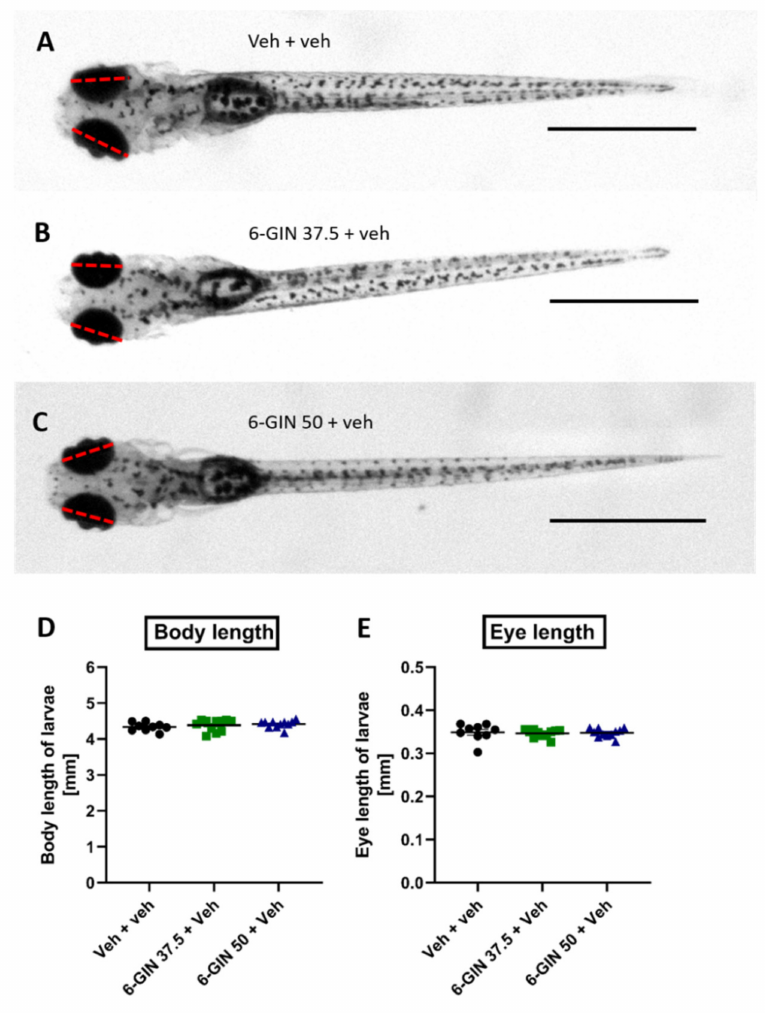
Figure 3. Larvae treated with 6-GIN are morphologically indistinguishable from their Veh-treated counterparts. ( A ) Larva treated with Veh for 24 h ( n = 9). ( B ) Larva treated with 37.5 µ M 6-GIN for 24 h ( n = 11). ( C ) Larva treated with 50 µ M 6-GIN for 24 h ( n = 11). ( D ) Comparison of body length of Veh- and 6-GIN-treated larvae ( E ) Comparison of eye length of Veh- and 6-GIN-treated larvae. Red dash lines represent how eye length was measured, scale bar = 1 mm. 6-GIN—6-gingerol,